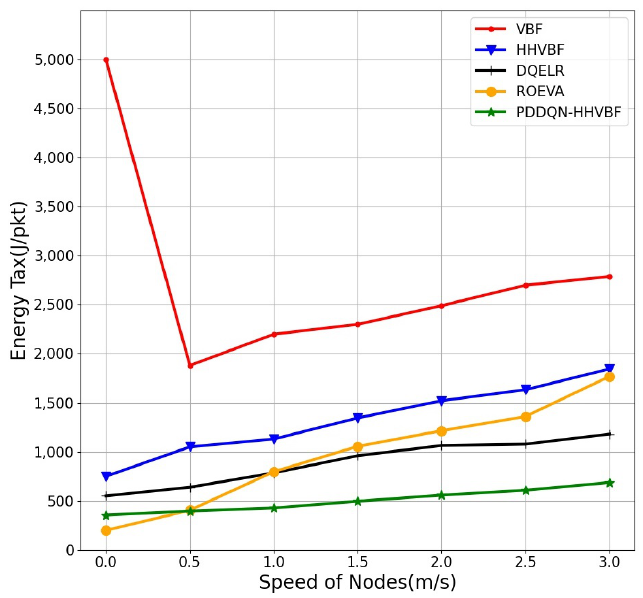
Figure 13. The energy tax of VBF, HHVBF, DQELR, ROEVA, and PDDQN-HHVBF protocol in different speed of